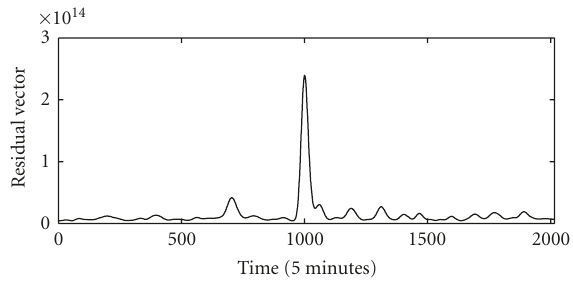
Figure 5: PCA for one anomalies in two flows.